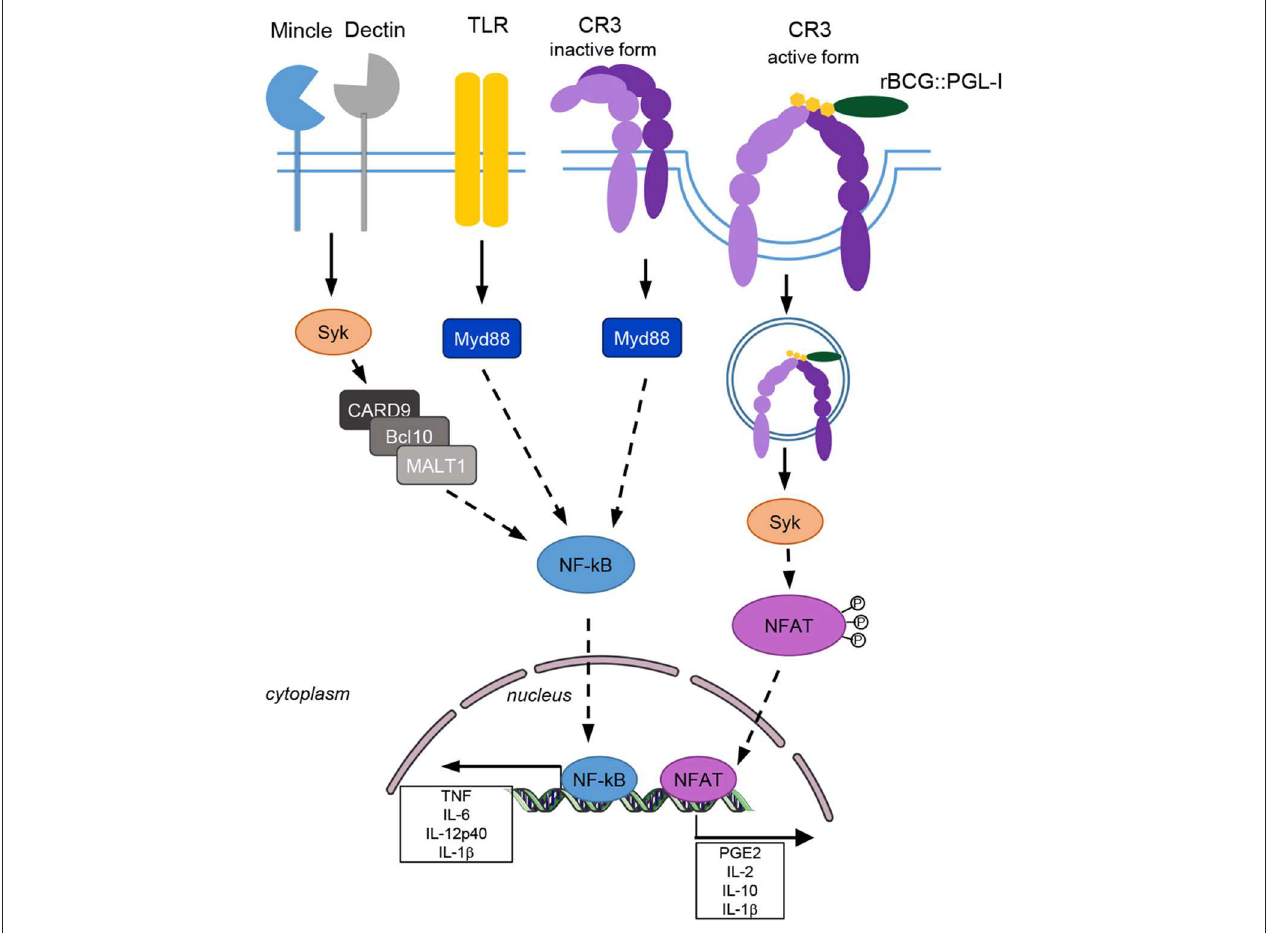
FIGURE 7 | CR3 triggers the Syk/calcineurin/NFATc pathway upon engagement by PGL-I-producing mycobacteria to rewire the innate response. rBCG::PGL-I targets the lectin domain of CR3 on the surface of DCs, PMNs, and MPs. Dectin-1 and CR3 cooperate to induce highly efficient entry of the bacilli. This triggers Syk for translocation of NFATc to the nucleus and initiates a transcriptional program to generate an NF- κ B-independent mediator signature. This preferentially PGL-I-triggered pathway does not depend on MYD88 even though both cooperate to induce maximum levels of these